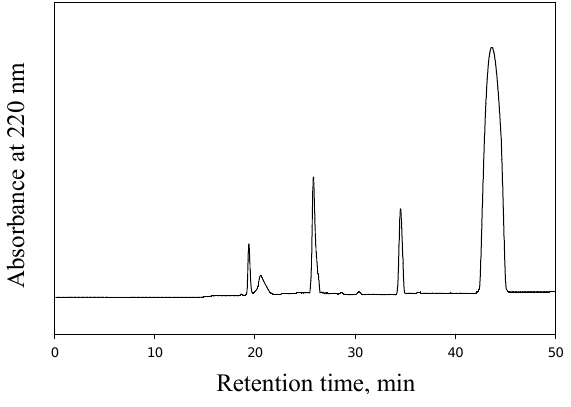
(Table 1). Retrorsine N -oxide formation in control and